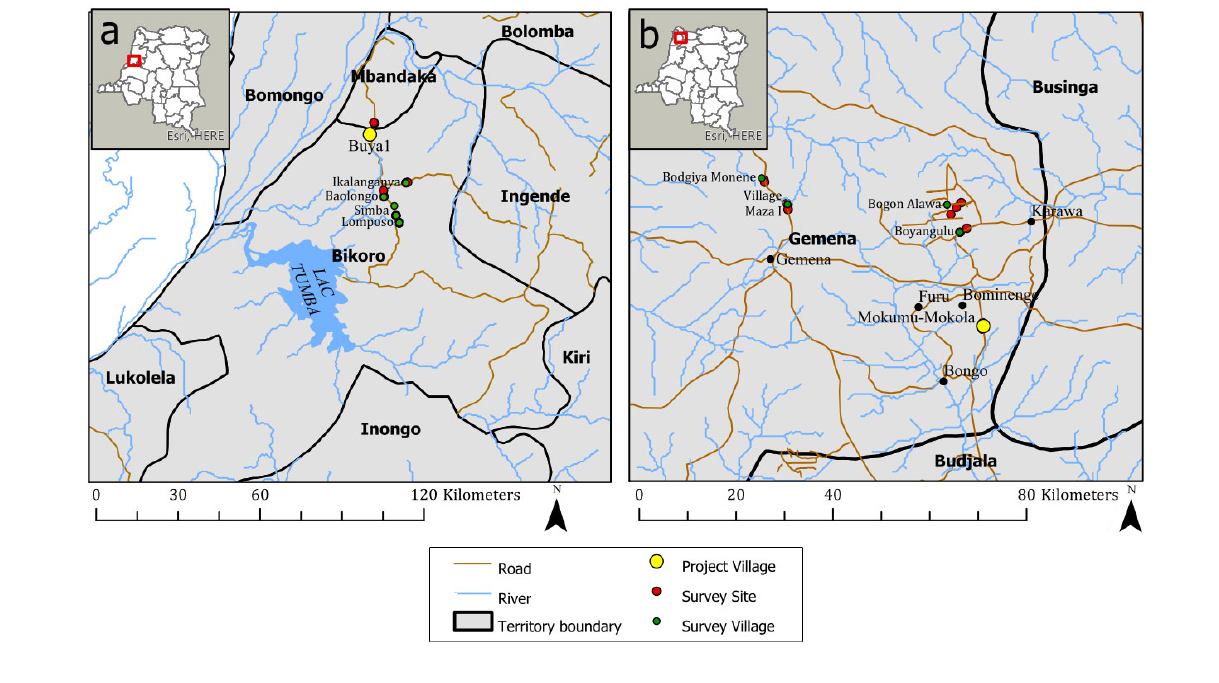
Fig. 1 . Map of the two pilot sites in Equateur province: (a) Bikoro territory, Buya 1 project village, (b) Gemena territory, Bokumu-Mokola project village. Source: M. Chapman, Wood Hole Research Center,